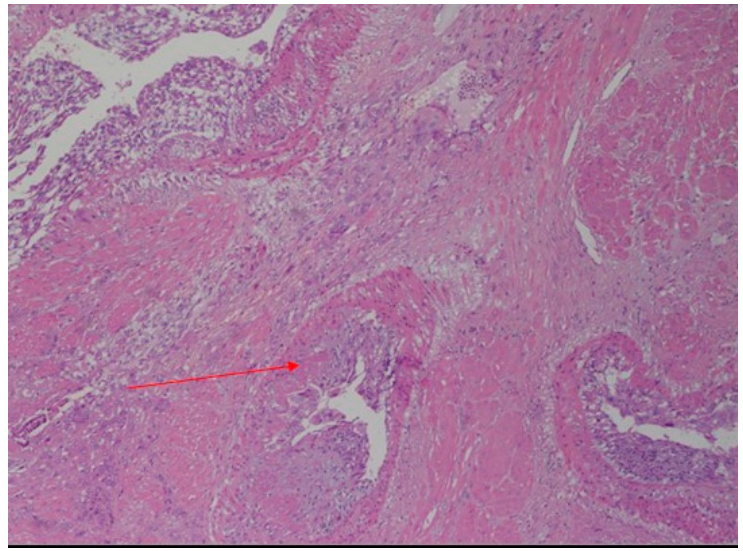
Figure 3. Higher magnification histological micrograph showing the decidualization of the muscle fibers (red arrow). (Hematoxylin-Eosin, Original Magnification: 10×).